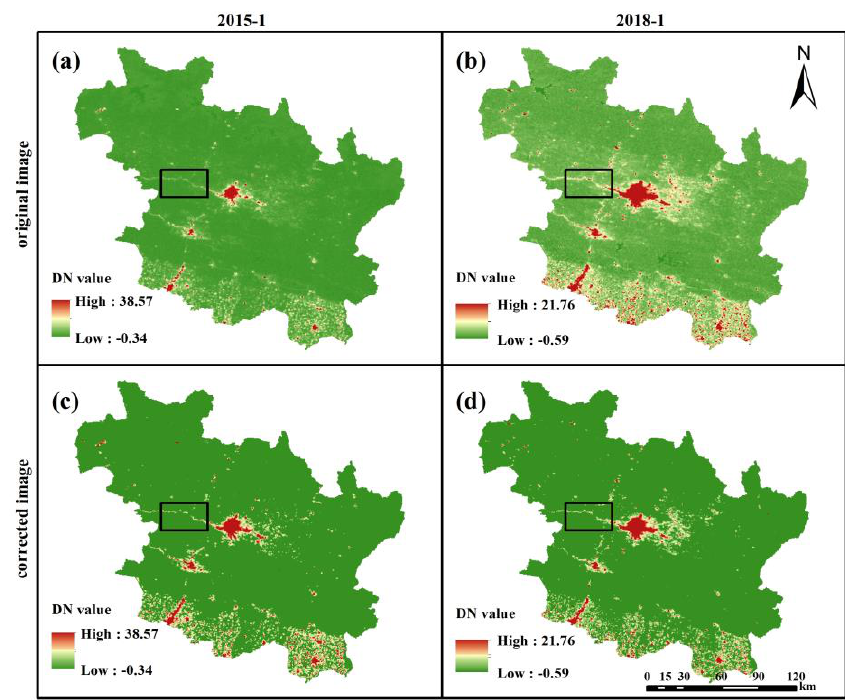
Figure 6. ( a ) The original and ( c ) corrected images in January 2015; ( b ) the original and ( d ) corrected images in January 2018.